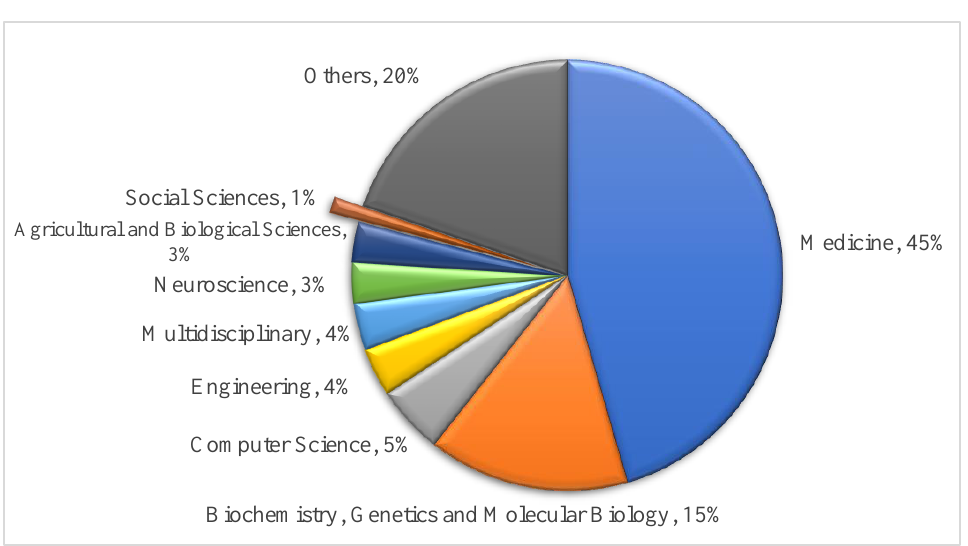
Figure 1. Distribution of publications including acronym “ROC” according to subjects.